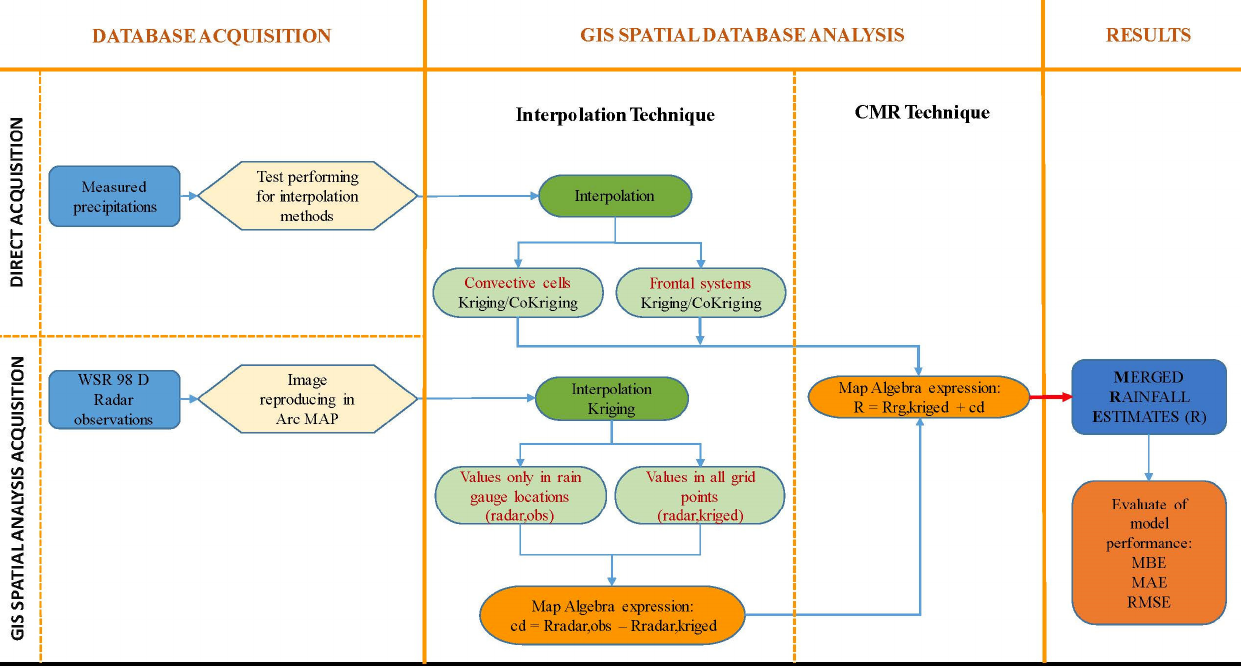
Table 1. Rainfall events between